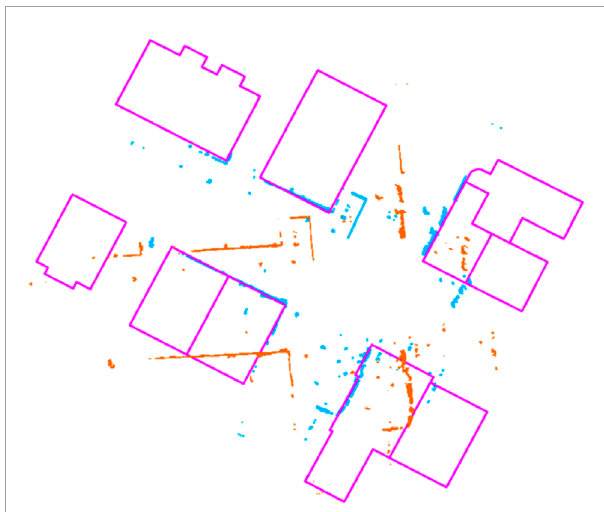
FIGURE 4 Example of alignment between the 2D buildings’ map from OSM (pink) and the 2D map extracted from LiDAR scan (orange). The aligned point cloud (blue) correctly overlaps the buildings’ map.